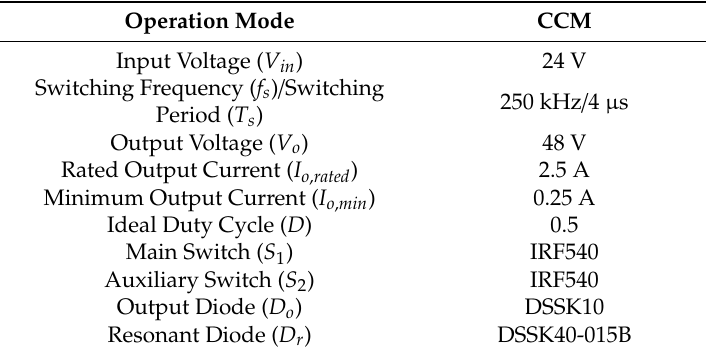
Table 1. System and specifications (CCM: continuous conduction